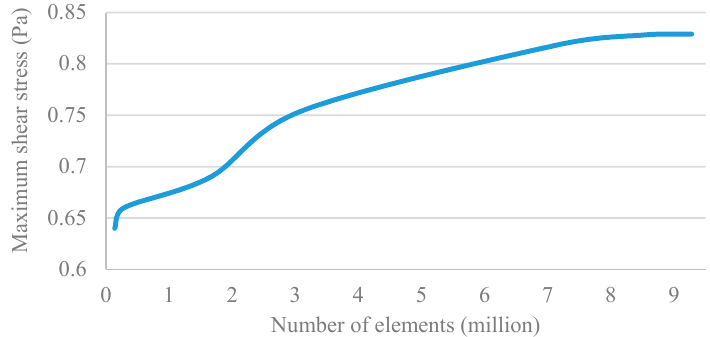
Figure 5. The influence of the numbers of mesh elements on the CFD calculation results.